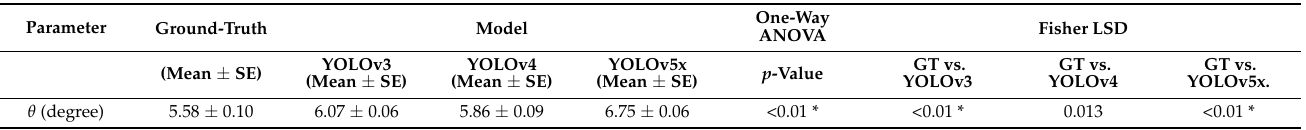
Table 2. One-way ANOVA of FPA comparison between the ground-truth angle and different YOLO